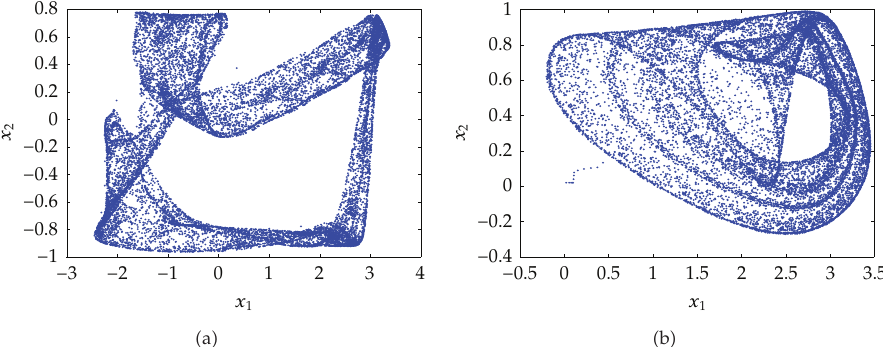
Figure 5: (cid:4) a (cid:6) Phase plot in space (cid:4) x 1 ,x 2 (cid:6) for system (cid:4) 4.1 (cid:6) with initial condition (cid:4) 0.02,0.02 (cid:6) and d 1 (cid:7) 3 . 9. (cid:4) b (cid:6) Phase plot in space (cid:4) x